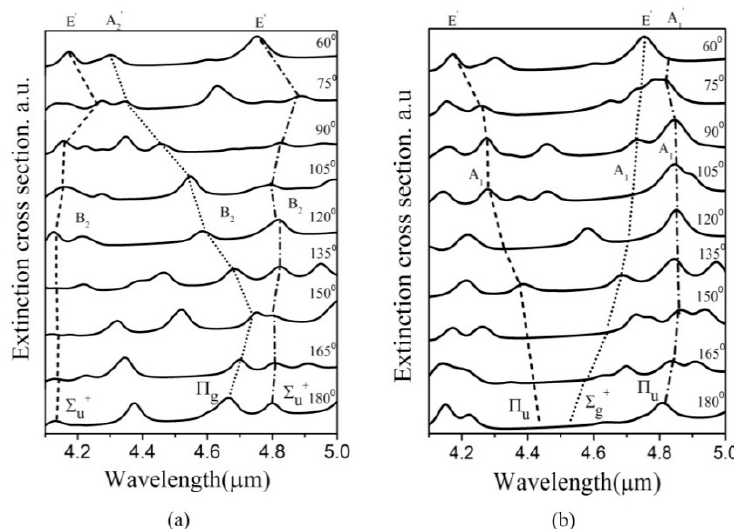
Figure 8. Extinction cross-section spectra of graphene trimers with 0.6 eV chemical potential under linearly polarized mid-infrared light. ( a ) B 2 modes that are optically active with longitudinal polarization, ( b ) A 1 modes that are optically active with vertical polarization. Compared with those of 0.5 eV graphene, the corresponding peaks in the spectra show blue shift.